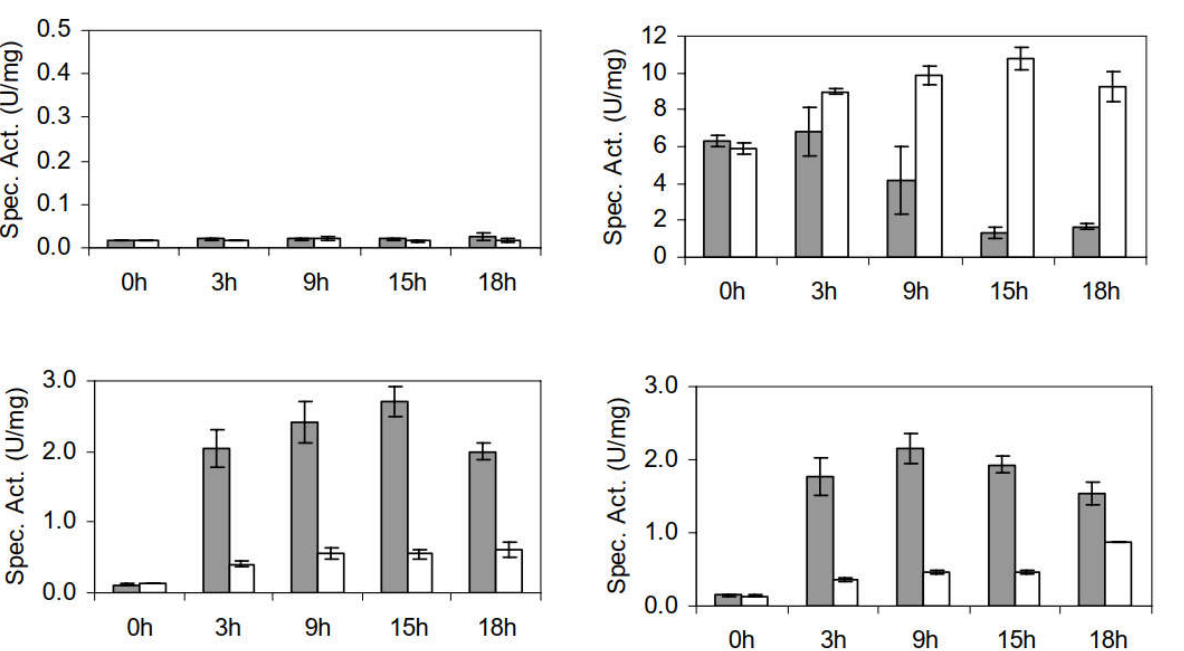
Figure 5. HMF ( left column ) and furfural ( right column ) reduction activity measurements in crude cell extracts from yeast cells cultivated in fed-batch mode using either spruce hydrolysate (SH; grey bars) or sugar medium (SM; white bars). Activity was measured using either NADH ( top row ) or NADPH ( bottom row ) as cofactor.